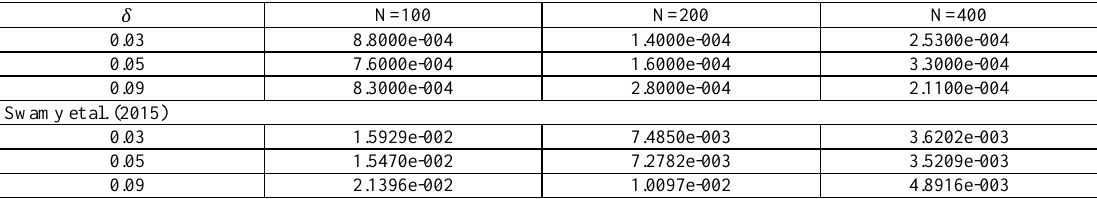
Table 6. Maximum absolute error obtained for Example 4 for 𝜺 = 𝟎. 𝟏 and for different values of N